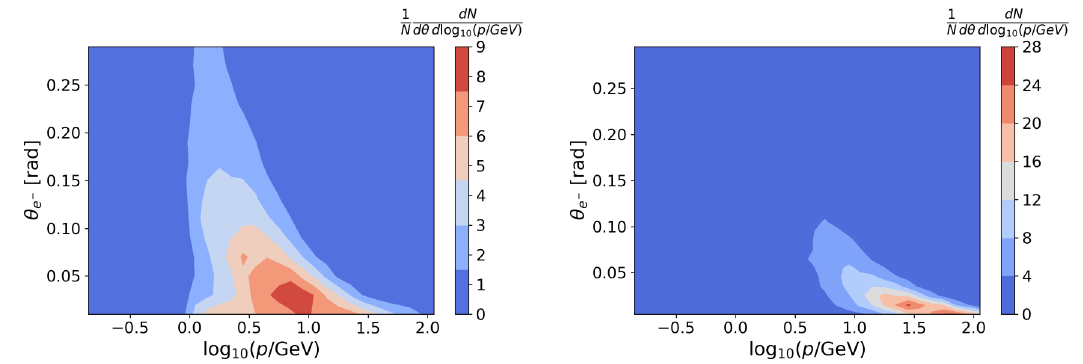
Figure 7. 2D contour plot of the momentum ( p ) and the production angle ( θ ) correlation for the η s produced in the collisions of 400 GeV protons hitting the SHiP beam-dump target. Left: simulation with FairShip including η production in the interactions of secondary hadrons with the target nuclei. Right: simulation of the prompt proton-nucleon η production with Pythia